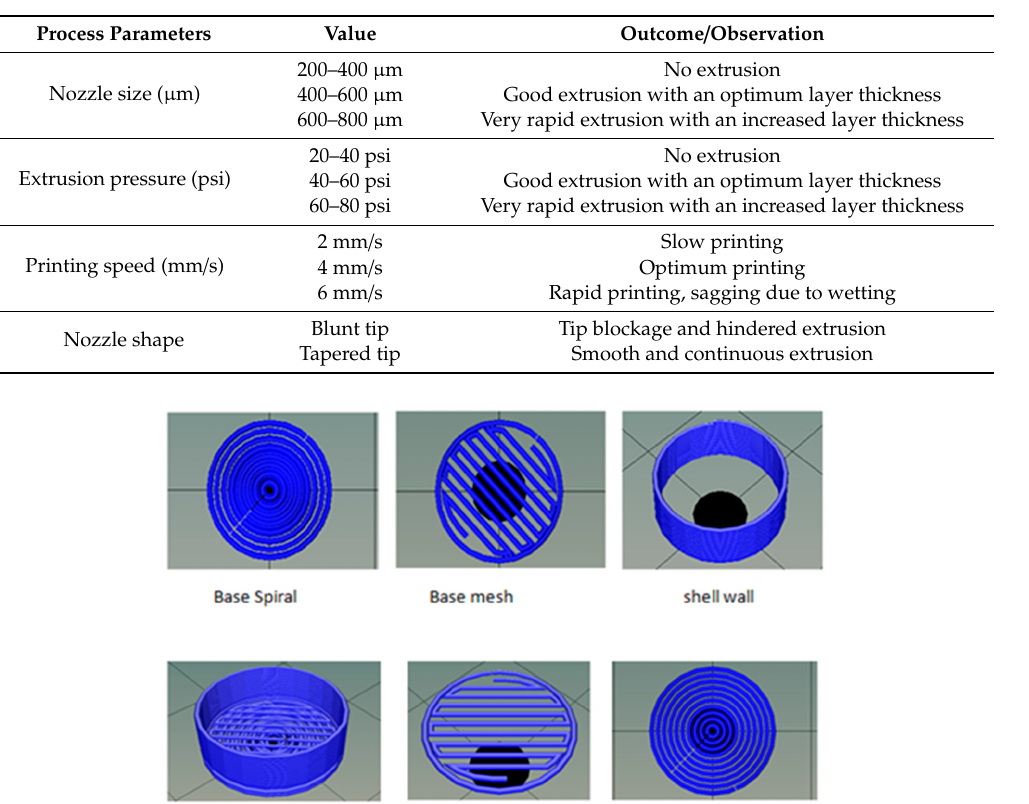
Table 2. Optimization for the extrusion-based 3D printing process for printing controlled-release tablet